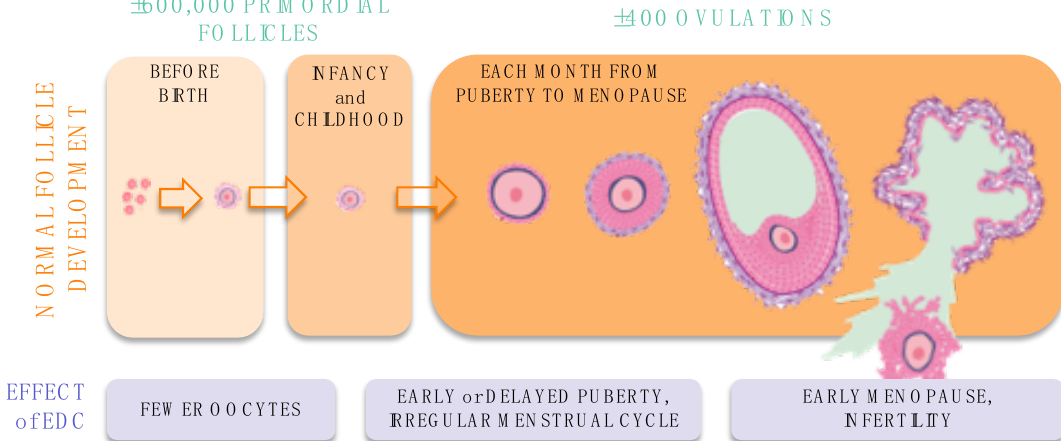
Figure 1. Stages of oocyte development: disruption by EDCs at different life stages leads to different reproductive effects in women. EDC, Endocrine Disrupting Chemical.